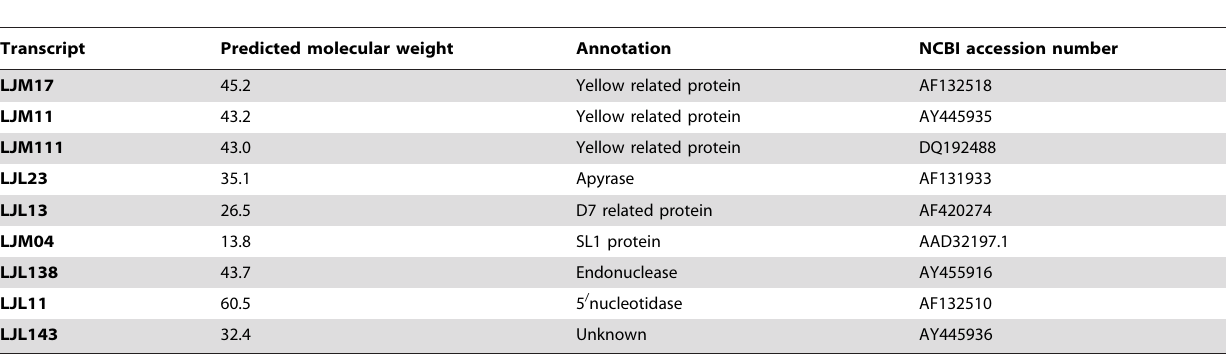
Table 1. Transcripts selected from a Lutzomyia longipalpis salivary gland cDNA library based on predicted molecular weight of secreted